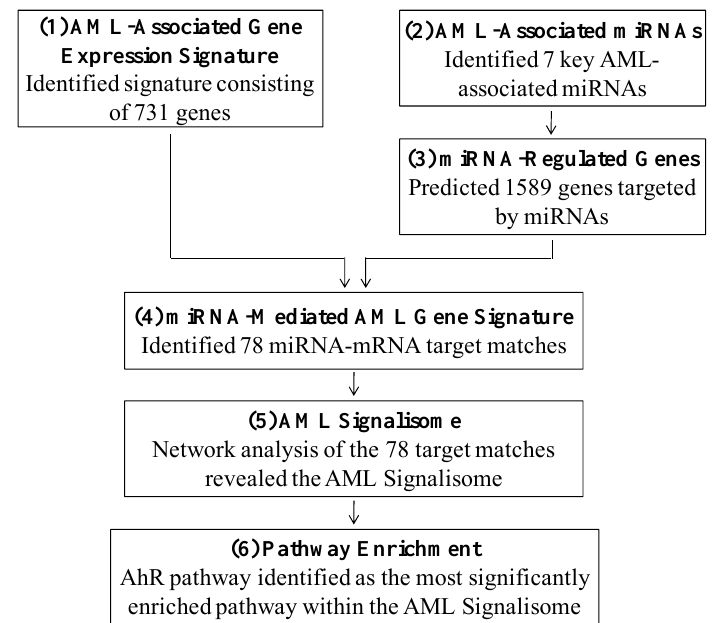
Figure 1. Steps in identifying the AML